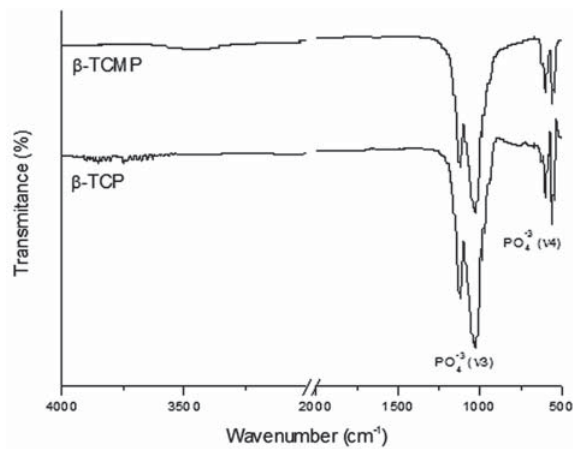
Figure 1- X-ray diffraction (XRD) patterns of tricalcium phosphate ( β -TCP) and magnesium-substituted β -TCP ( β -TCMP) heat-treated at 1000°C in air for 4 h